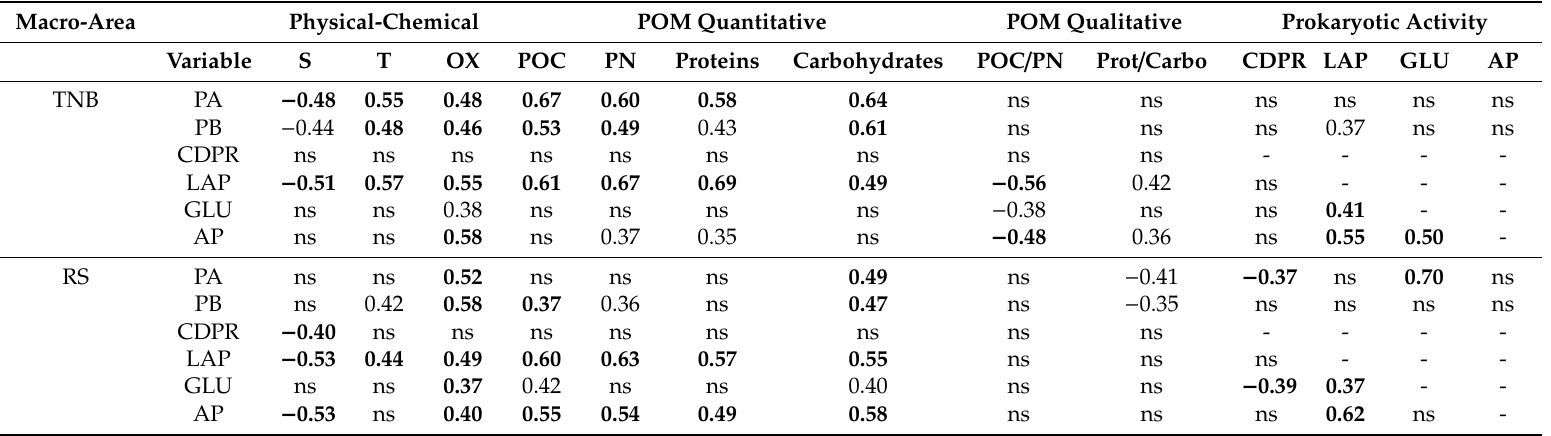
Table 2. Significant correlations (bold numbers: p < 0.01, thin numbers: p < 0.05, ns: not significant) between the prokaryotic characteristics and activities (PA, PB, CDPR, LAP, GLU and AP) and the other variables, grouped for: physical-chemical (S, T, OX), POM quantitative (POC, PN, proteins and carbohydrates), POM qualitative (POC / PN ratio and protein / carbohydrate ratio). Correlations among the prokaryotic activity variables are also provided. Coastal TBN: n = 36, except for PA, PB, and GLU ( n = 32). O ff shore RS: n =